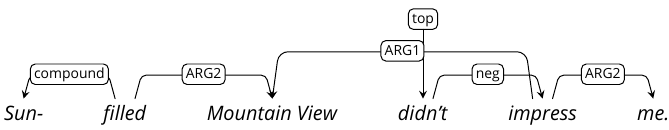
Figure 4: DM bi-lexical semantic dependencies for our running